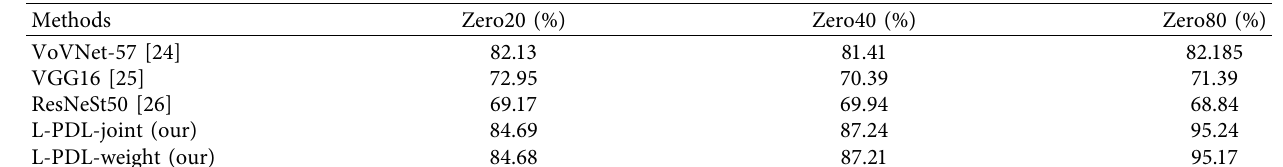
Table 2: Result on CIFAR-10.